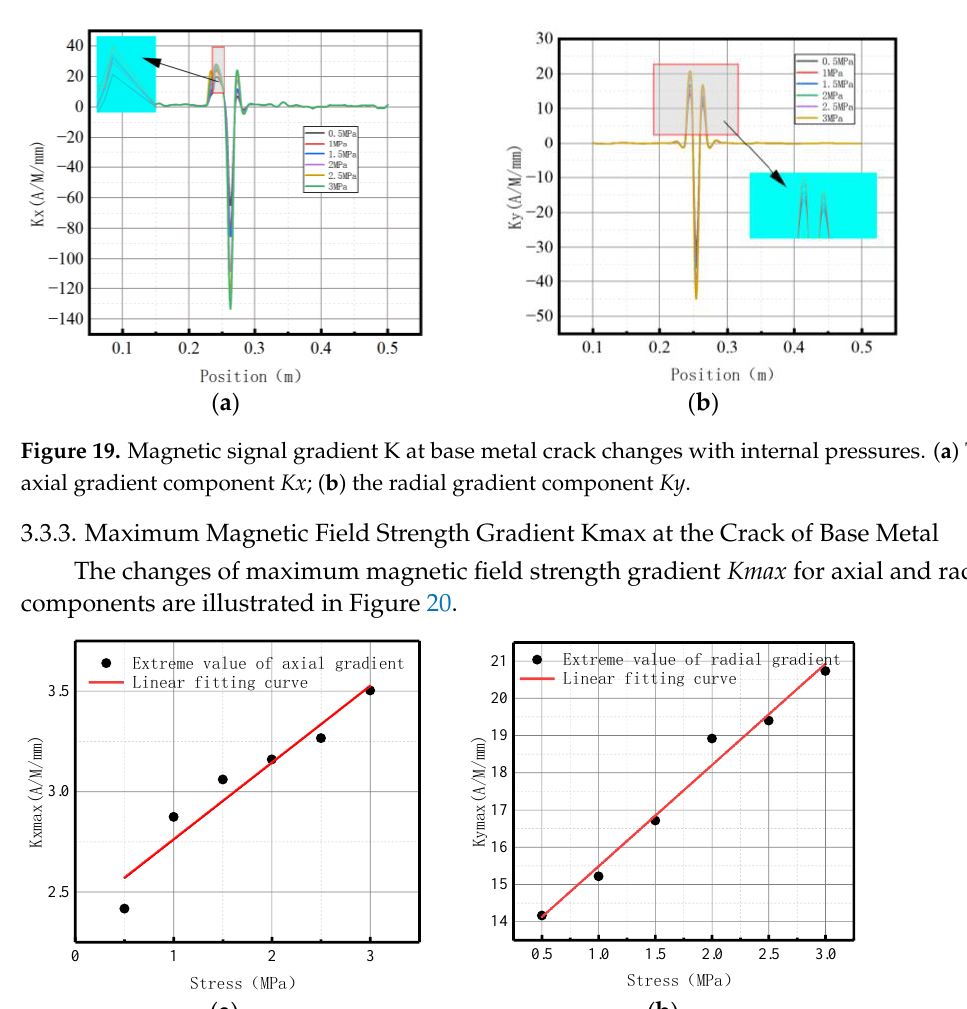
Figure 21. S ( K ) varies with the internal pressure. ( a ) Axial component of S ( k ); ( b ) radial component of S ( k ). It was revealed that S ( K ) in both axial and radial components increased linearly with the elevation of internal pressure. For an increase of pressure with an interval pressure of 0.5 MPa, the average change of S ( K ) in the axial component was 14.5, and it was 23.67 in the radial component. The year-on-year growth rate in the axial component ν x of energy factor S ( K ) was 64.15%; the year-on-year growth rate in the radial component ν y of energy factor S ( K ) was 77.5%. The year-on-year growth rate in the axial component was 13.35% higher than that in the radial component, indicating that the radial component of the mag- netic signal at the weld crack of ferromagnetic materials was more sensitive to the varia- tions of stress. From the perspective of magnitude and average change, S ( K ) had a greater variation than K and Kmax , and the variation may be more obvious. According to the above-mentioned parametric analysis of the weld, weld cracks, and base metal cracks, it was noted that the magnitude and average change of the proposed new parameter S ( K ) were larger than those of K and Kmax , thus, S ( K ) can be used as a new parameter to comprehensively assess the stress-induced damage of pipelines.